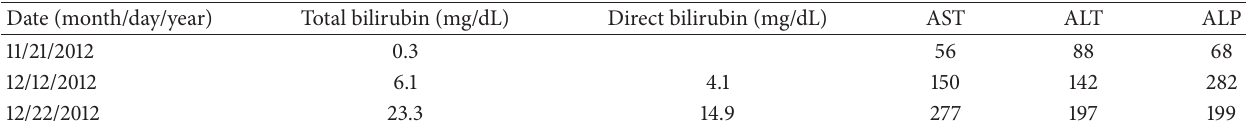
Table 1: Trend of patients LFTs.